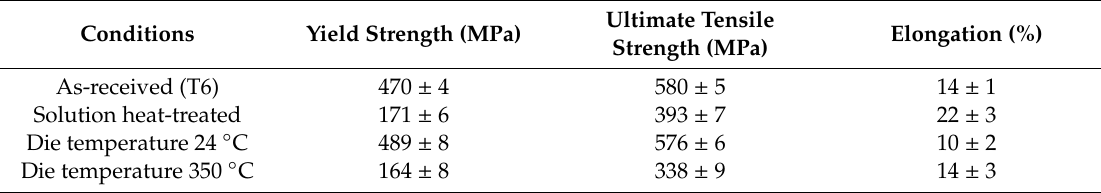
Table 2. Summary of the tensile tests performed at room temperature on AA7075 alloy in di ff erent conditions; standard deviations with the 80% confidence interval are provided in the table (partly recompiled from